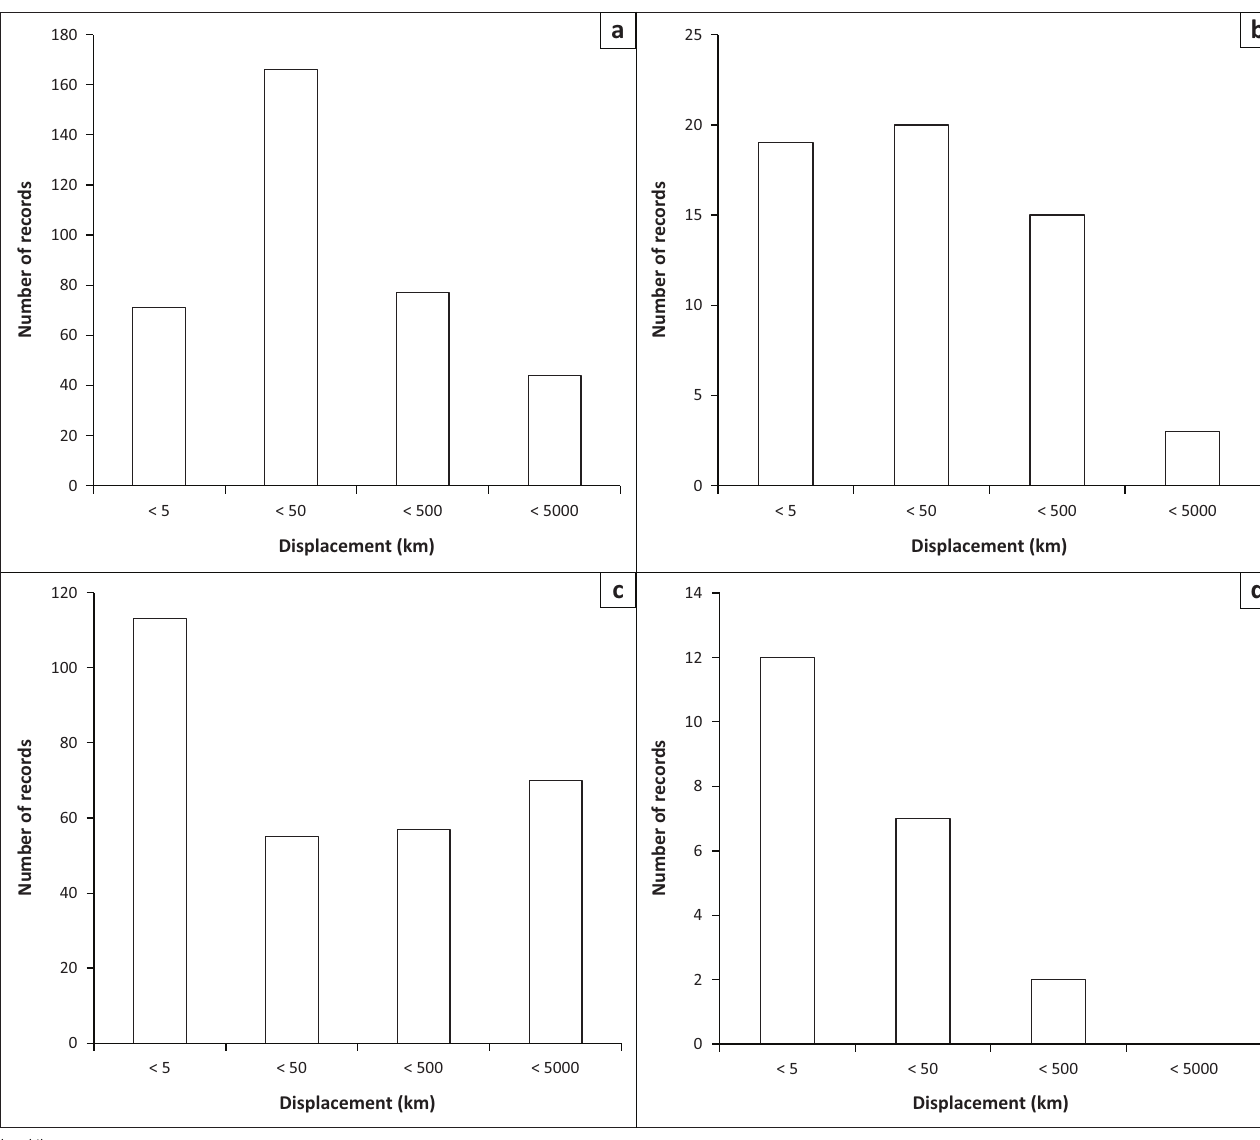
FIGURE 1: Number of (a) Cattle Egrets ( Bubulcus ibis ), (b) Black-headed heron ( Ardea melanocephala ), (c) Sacred Ibis ( Threskiornis aethiopicus ) and (d) Hadeda Ibis ( Bostrychia hagedash ) trapped, sighted or recovered having travelled 1 km – 5 km, 6 km – 50 km, 51 km – 500 km and 501 km – 5000 km, after being ringed as pulli or juveniles. These four species were selected based on having sufficient records to generate these